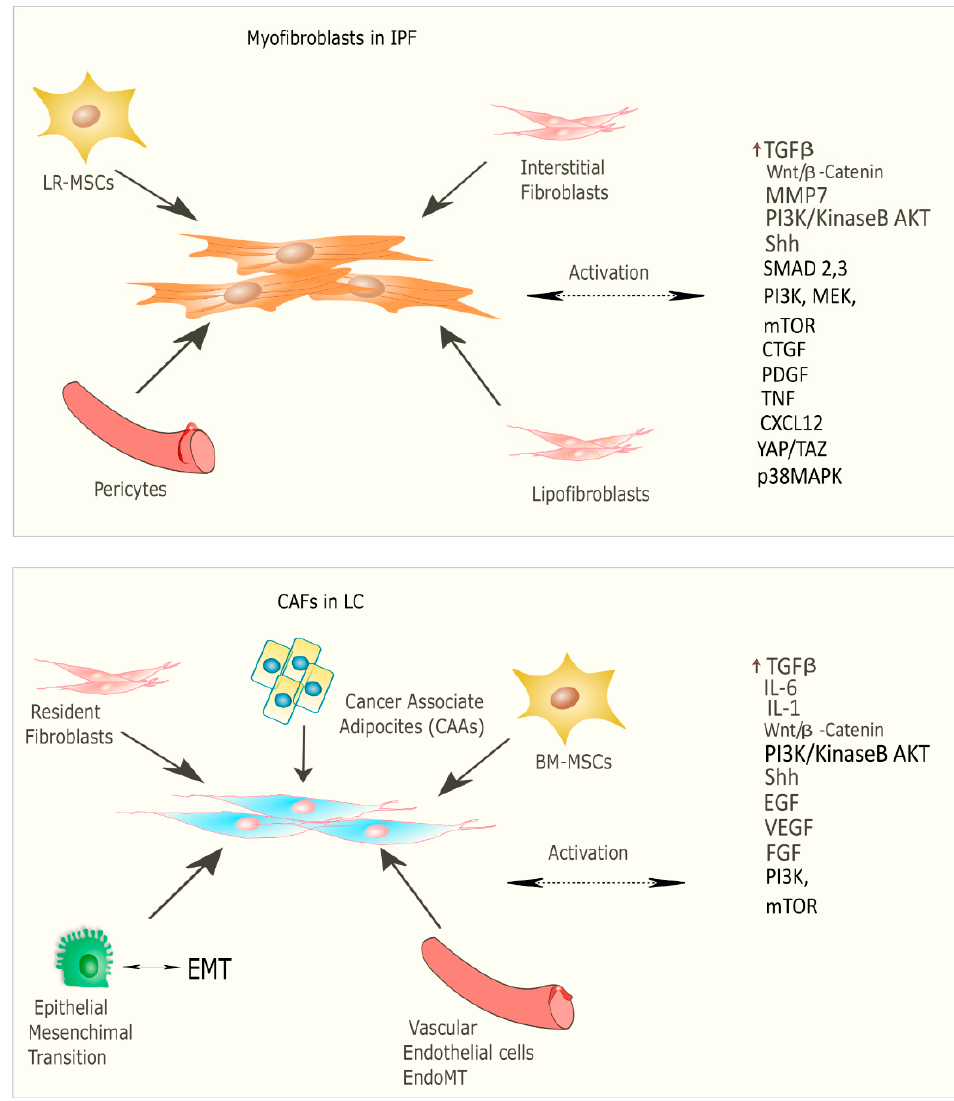
Figure 2. Origin and signalling pathway leading to the activation of myofibroblasts in IPF and CAFs in LC.